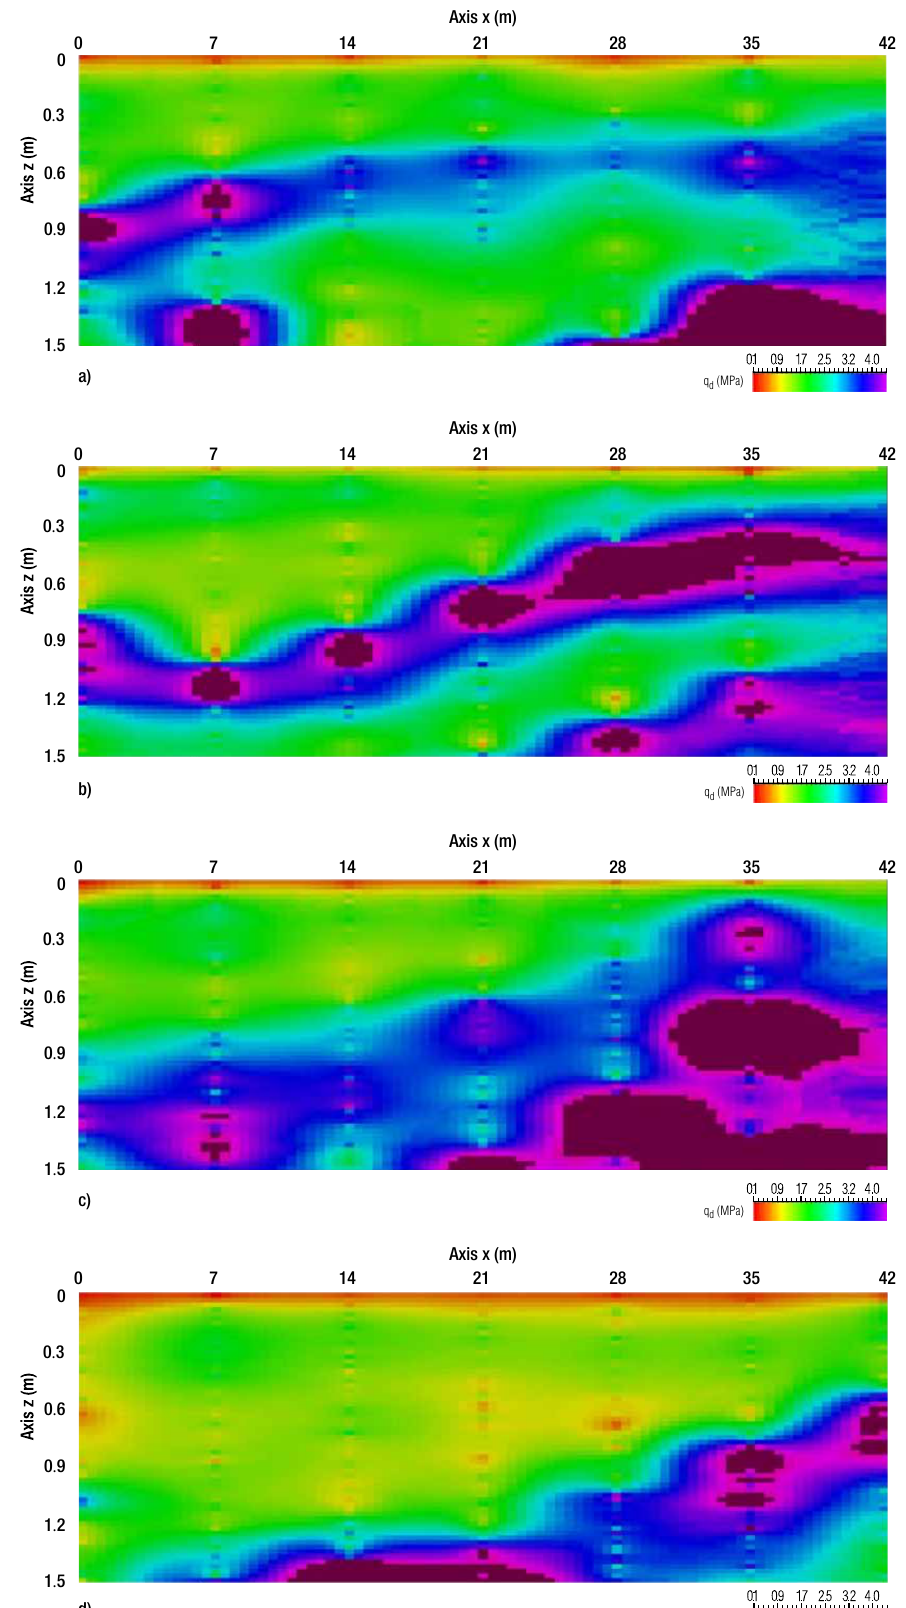
Figure 11. OK estimation of q d . yz-plane cross-sectional profile. ( a ) Test slab 1. ( b ) Test slab 2. ( c ) Test slab 3. ( d ) Test slab